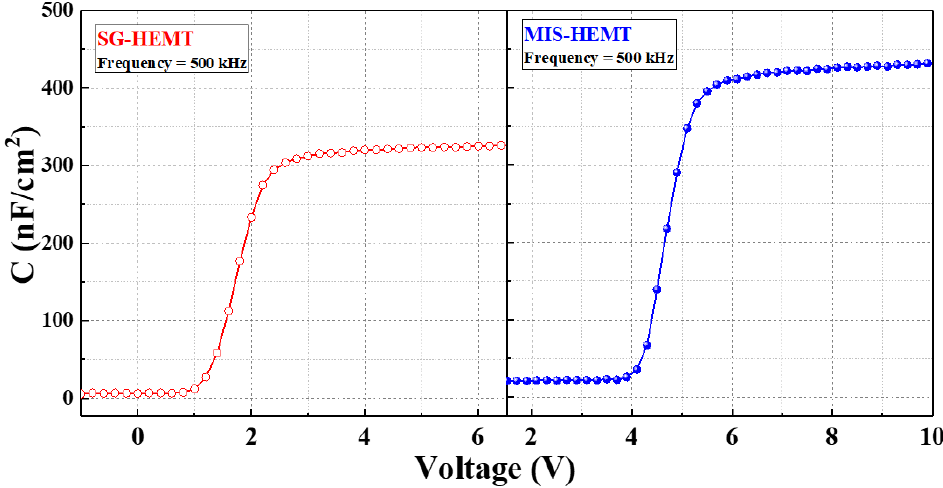
Figure 5. C – V characteristics of SG-HEMT and MIS-HEMT. Figure 5. C–V characteristics of SG-HEMT and